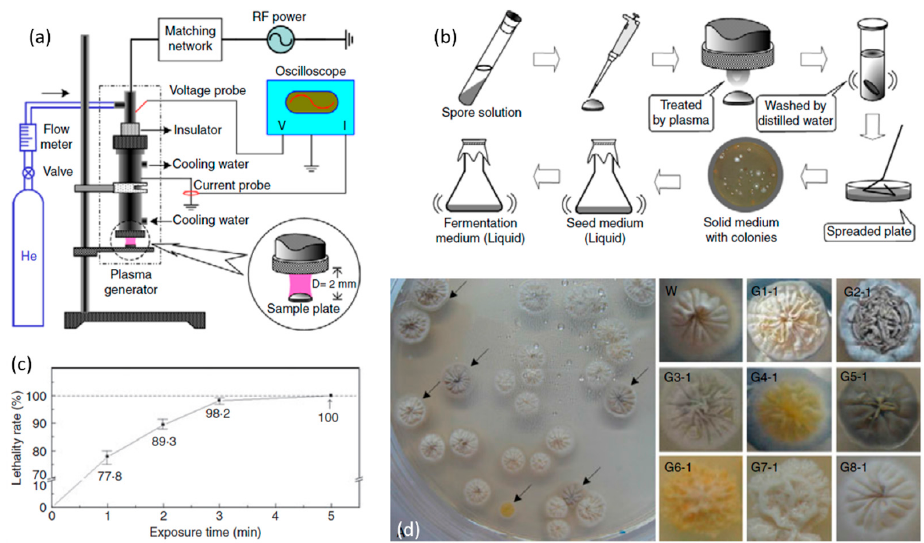
Figure 16. ( a ) The atmospheric radiofrequency (RF) atmospheric pressure He glow discharge used by Wang et al. [277], ( b ) schematic presentation of their mutation breeding protocol, ( c ) variation of the lethality rate with plasma exposure time and ( d ) images of the colonies before and after mutation; (left) a cultivated plate of the strains from plasma-treated spores, (W) a colony from the untreated wild strain, (Gm-1 (where m = 1–8)) the selected mutants from plasma-treated spores. Reprinted with permission from [277].